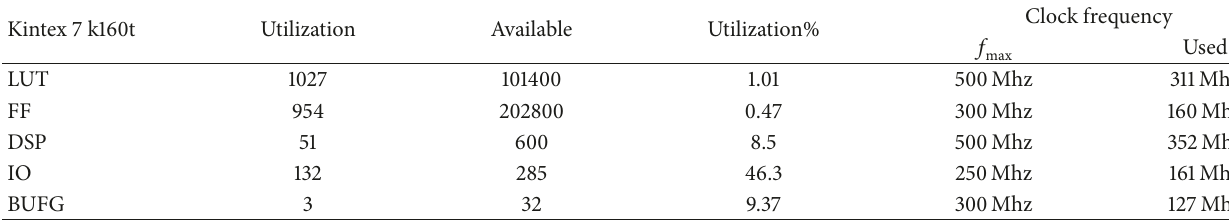
Table 2: Resources utilized by the FOSG